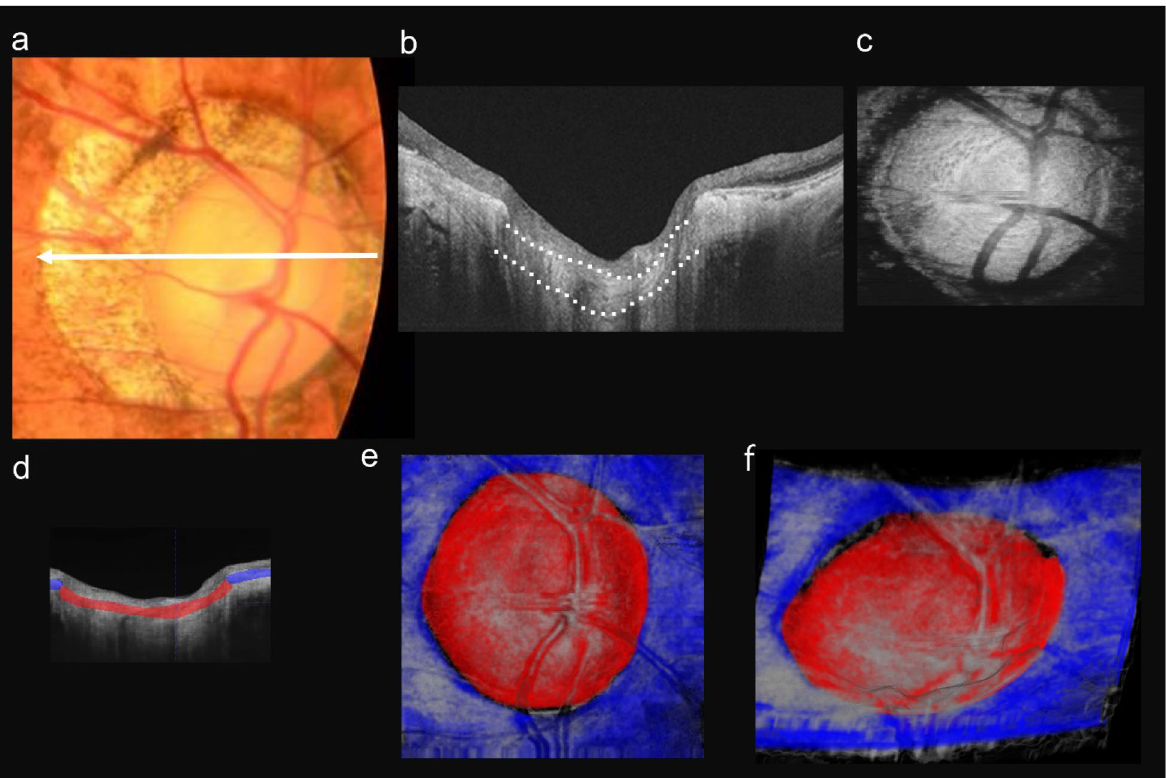
Figure 2. Color fundus photographs and OCT images of a 61-year-old highly myopic woman without a lamina cribrosa defect (LCD). ( a ) Color fundus photograph showing the optic disc of the right eye. A myopic conus is present in the peripapillary area temporal to the optic disc. White arrow shows scanning line for the OCT images. ( b ) Horizontal OCT cross-sectional image showing the lamina cribrosa (LC) (white dotted lines). ( c ) En face OCT image of the optic disc at the level of the LC. The LC appears as a round hyperreflective area and laminar pores are seen as hyporeflective dots within the area of the LC. The temporal edge of the LC is unclear due to signal attenuation by the surrounding tissues. ( d ) OCT image as (b) with manual labels showing the PPS colored blue and the LC colored red. ( e , f ) 3D images generated by the trained deep convolutional neural network. ( e ) En face 3D image shows that the LC is surrounded by the PPS. ( f ) 3D image viewed from inferior side of fundus shows that the LC is bent against the PPS curvature and forms the optic disc